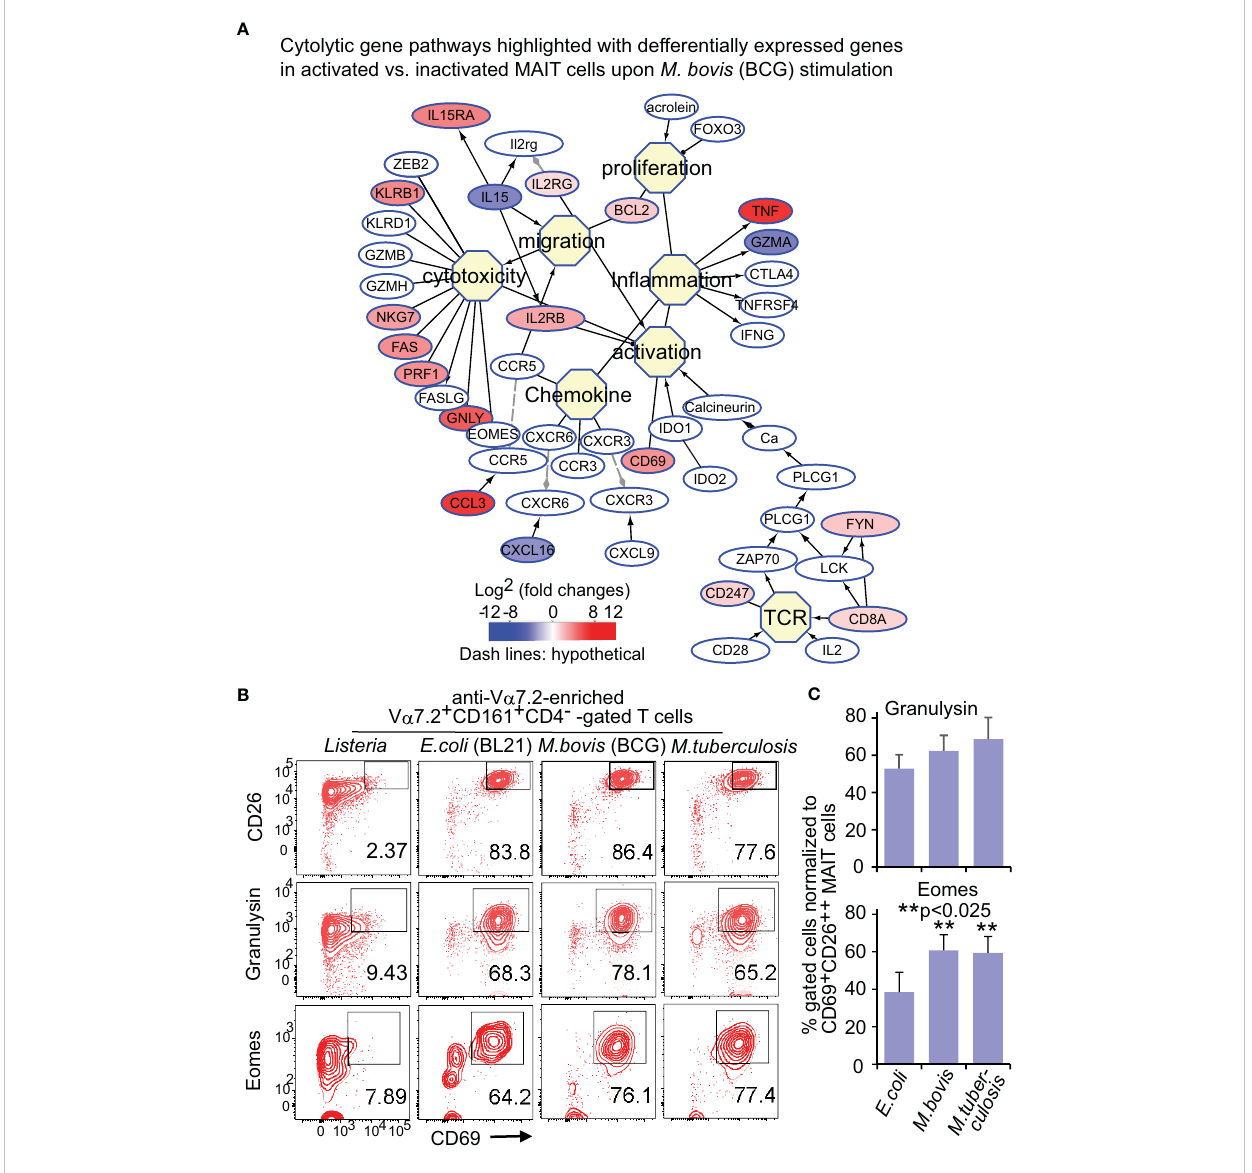
FIGURE 3 BCG and E.coli stimulate differential gene and protein expression of MAIT cells in cytotoxic pathways. Similar to Figure 2, DEGs between activated (CD69 + CD26 ++ ) subsets versus inactivated (CD69 +/- CD26 +/- ) subsets of CD8 + MAIT cells upon BCG stimulation were annotated in pathways of cytotoxic T cell responses (A) . Protein expression of key effect molecule granulysin and key transcription factor Eomes were con fi rmed with the percentage of CD69 + granulysin + or CD69 + Eomes + subsets in comparison to the CD69 + CD26 ++ subset of CD8 + MAIT cells detected by fl ow cytometry (B) . The gating strategy is shown in Figure S1 as well. The percentage of CD69 + granulysin + or CD69 + Eomes + subsets of CD8 + MAIT cells were normalized with the percentage of activated CD69 + CD26 ++ subsets of CD8 + MAIT cells. Plots show the means of these normalized percentages and standard error from multiple donors. A pairwise t-test was used to determine the signi fi cance of differences between BCG and E. coli stimulations (C)